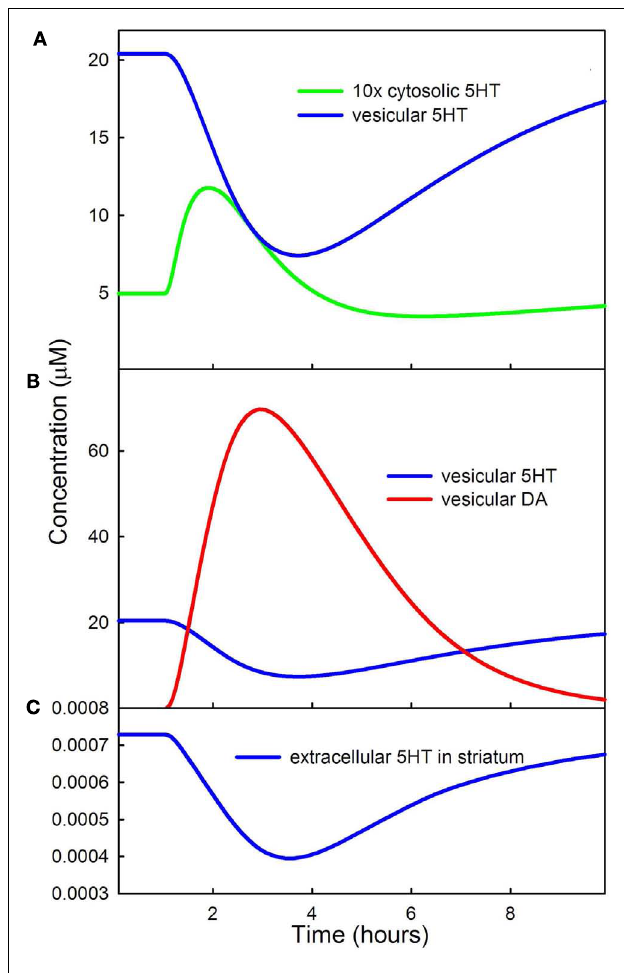
FIGURE 4 | Effects of LD on cytosolic, vesicular, and extracellular 5HT. (A) Shows that vesicular 5HT declines by more than 50% during the LD dose because of the competition of 5HT and DA forVMAT.The initial rise in cytosolic 5HT is caused by backflow from the vesicles as vesicular input of 5HT declines. (B) Shows that DA concentration in the vesicles during the dose is much greater than 5HT concentration. (C) Shows the decline of extracellular 5HT in the striatum during the LD